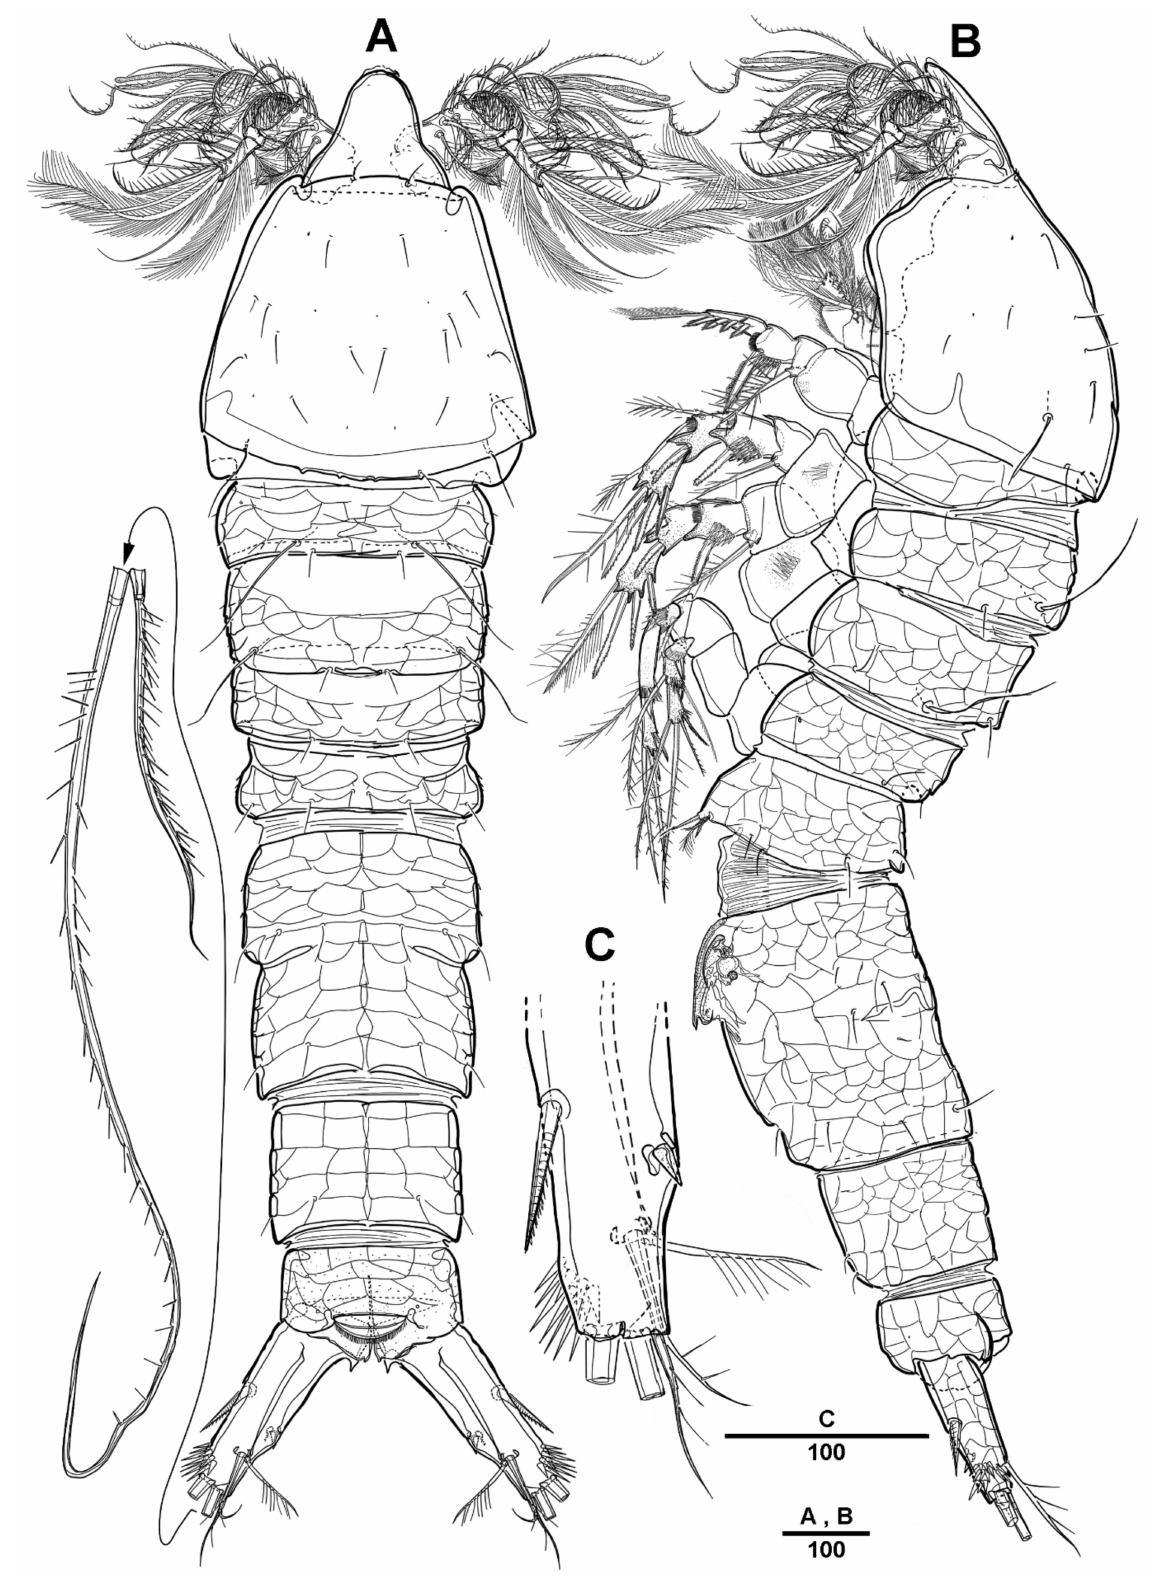
Figure 12. Scottolana wonchoeli sp. nov. holotype female: ( A ) habitus, dorsal; ( B ) habitus, lateral; ( C ) right caudal ramus, ventral. Scale bars in µ